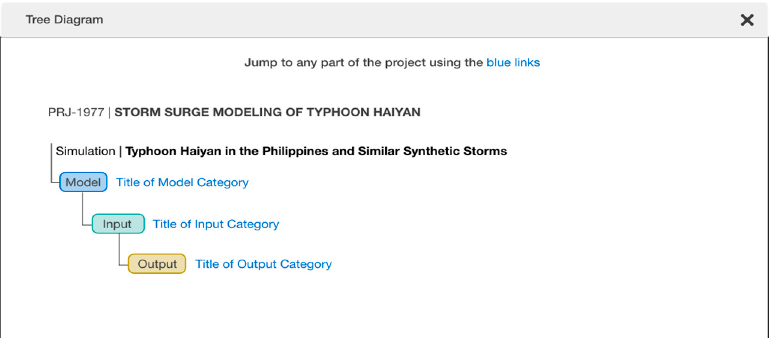
Figure 8. Browsing view of a complete simulation dataset.